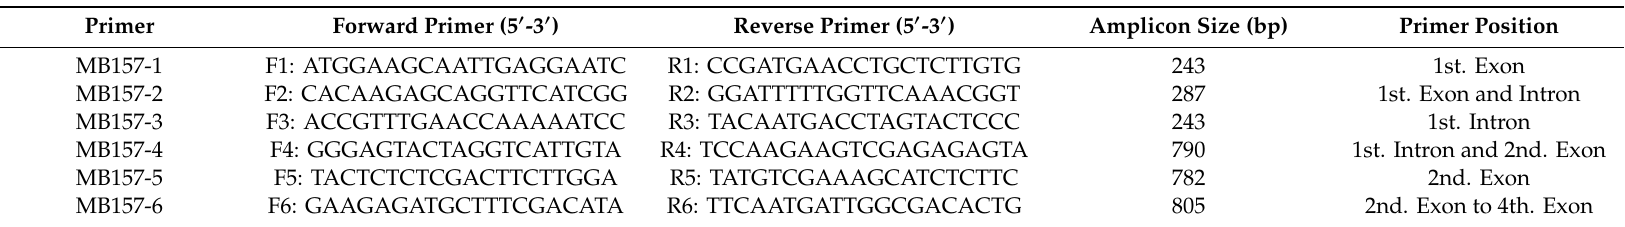
Table 3. List of primers designed along the entire length of gene MELO3C022157 to narrow down the position of length polymorphism and to clone the